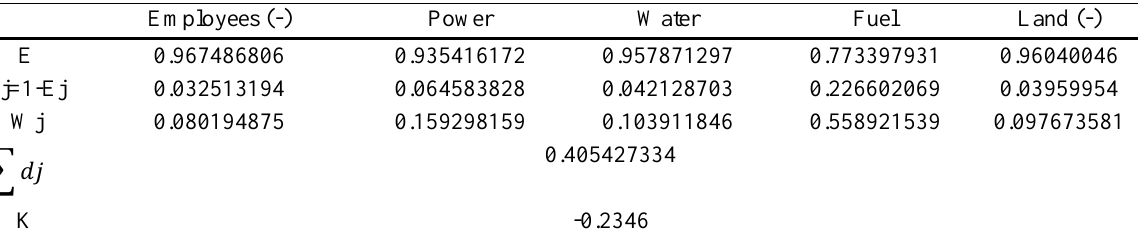
Table 3. Weighted values based on Entropy Shannon procedure.